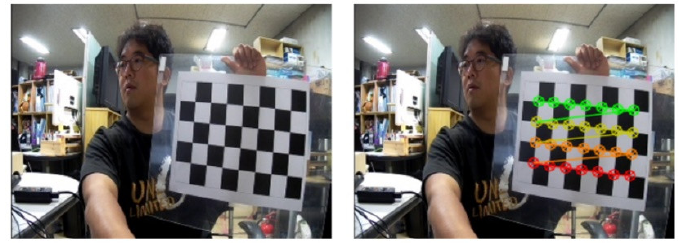
Figure 4. Feature point extraction using a chess board.